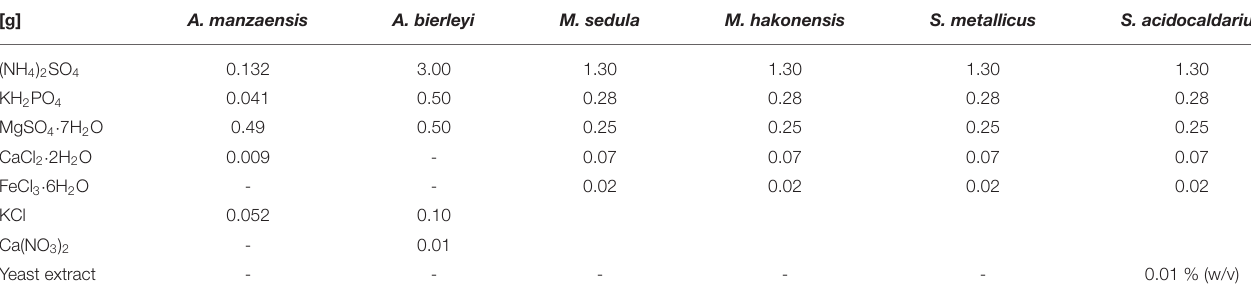
TABLE 1 | Detailed microbiological media composition for the six thermoacidophilic